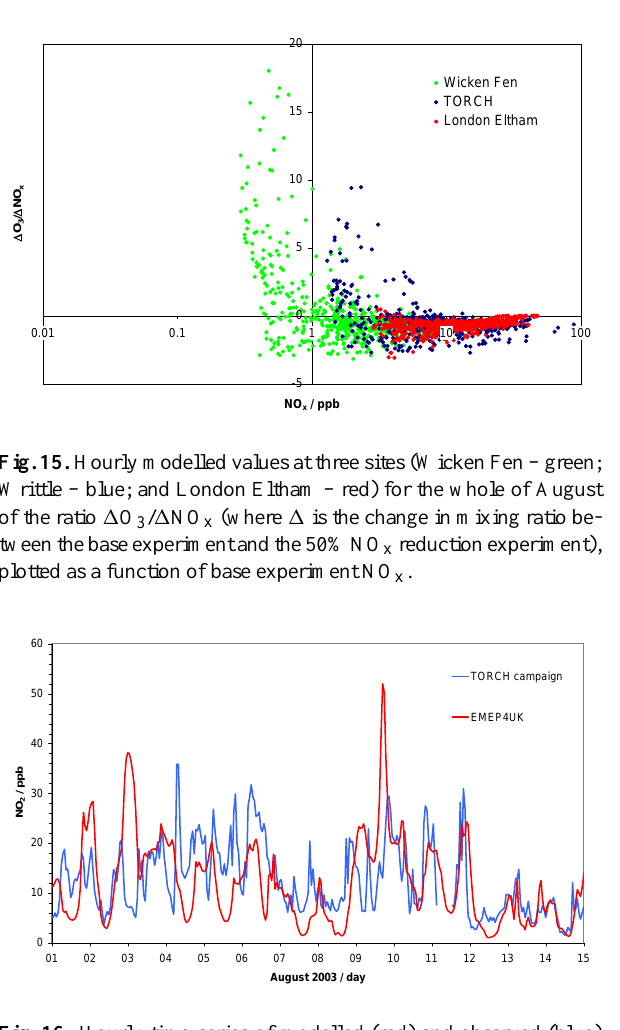
Fig. 16. Hourly time-series of modelled (red) and observed (blue) surface NO 2 (ppb) during August 2003 at Writtle.